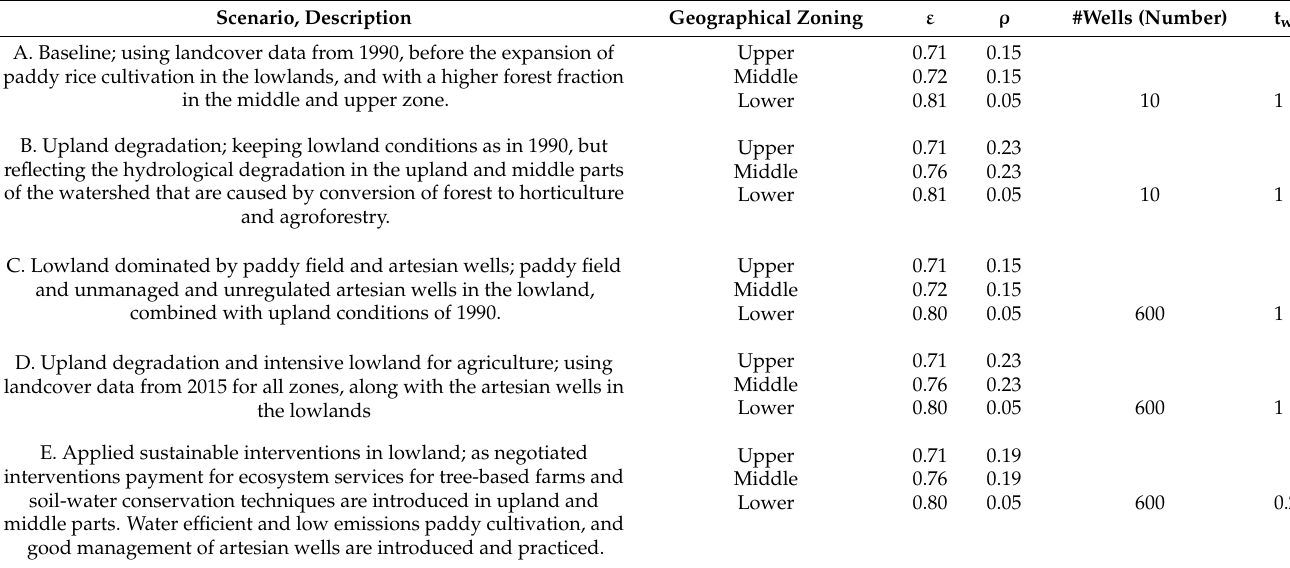
Figure 4. Measured flow of around 450 artesian wells in lowland Rejoso area; data source: [16]. After parameterizing this simple model (Appendix A), we compared five scenarios: (A) a historical reference scenario, (B) upland degradation, (C) lowland conversion to paddy with uncontrolled artesian wells, (D) combining the changes of (B + C, E) a restoration scenario with agroforestry in upper and middle zones and reduced groundwater use in the lowland paddy zone (Table 1). Table 1. Scenarios of the Rejoso water balance model; t w indicates the fraction of time the artesian wells are flowing; the evapotranspiration ratio ε was estimated from land cover composition and known temporal dynamics of Leaf Area Index of the vegetation; the ρ coefficient from existing runoff